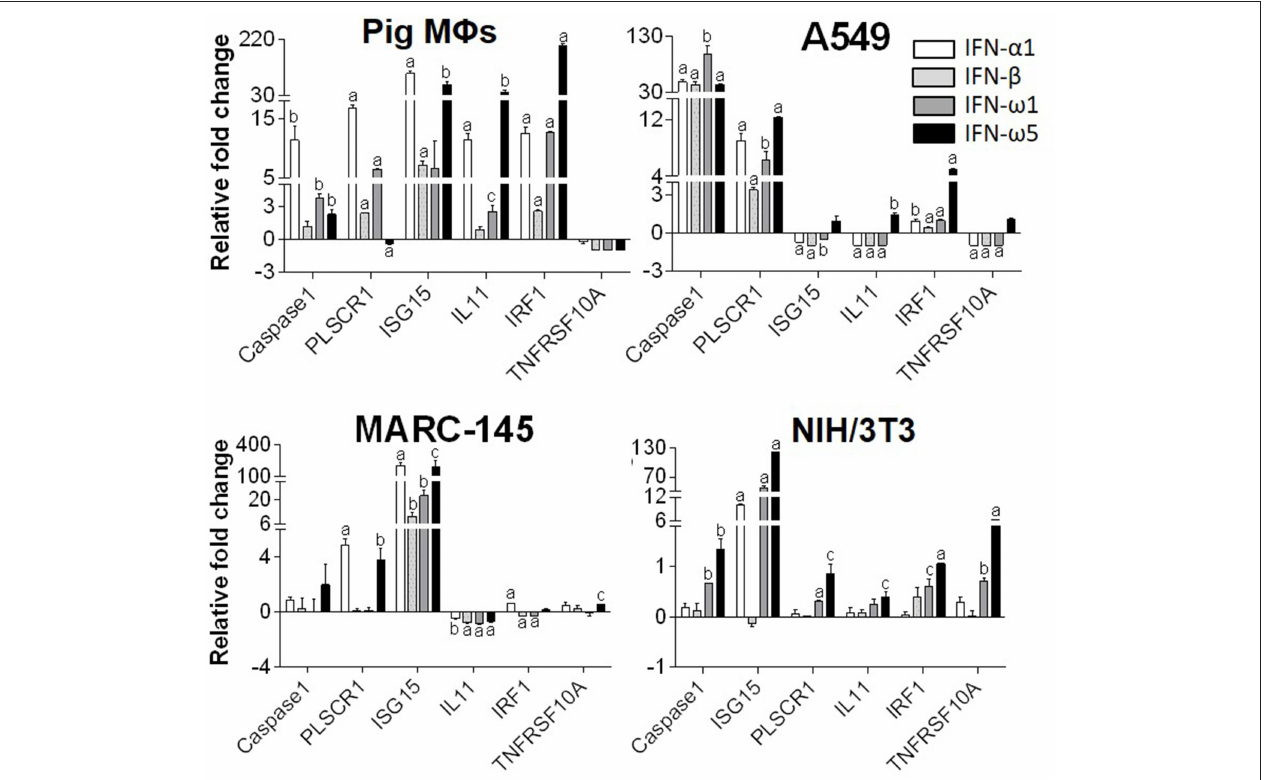
FIGURE 7 | Differential induction of IFN-stimulated genes (ISGs) by porcine IFN peptides in porcine (M Φ s), monkey (MARC-145), human (A549), and mouse (NIH3T3) cells. Cells at 80% confluence were treated with overexpressed IFN peptides (20ng/ml) for 24h. Gene expression was analyzed using a SYBR Green-based real-time RT-PCR assay. Total RNA (100 ng) was used in each 20 µ l of PCR reaction. Ct values of the genes were normalized against Ct values of a housekeeping gene (beta-actin) amplified from the same RNA samples to obtain 2 − 1 Ct , which reflects the expression of each ISG relative to beta-actin and were further normalized for fold changes to the control (mock). CASPAS1, caspase 1; IL11, interleukin 11; IRF1, IFN-regulatory factor 1; ISG15, ubiquitin-like IFN stimulated gene 15; PLSCR1, phospholipid scramblase 1; TNFRSF10A, tumor necrosis factor alpha receptor superfamily 10A ( 10, 24). Data are means ± SE; n = 3 replicates of 2–3 independent assays, a, b, and c: p < 0.001, 0.01, and 0.05, respectively, compared to control.